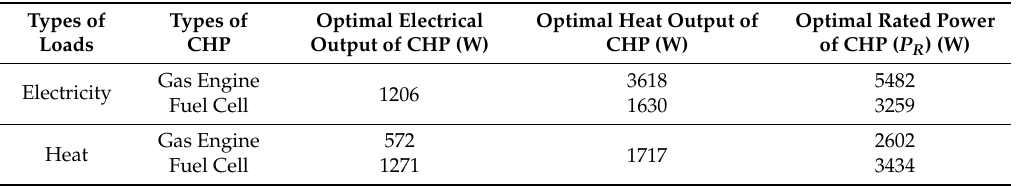
Table 3. Optimal capacities of different types of CHP based on different types of loads.